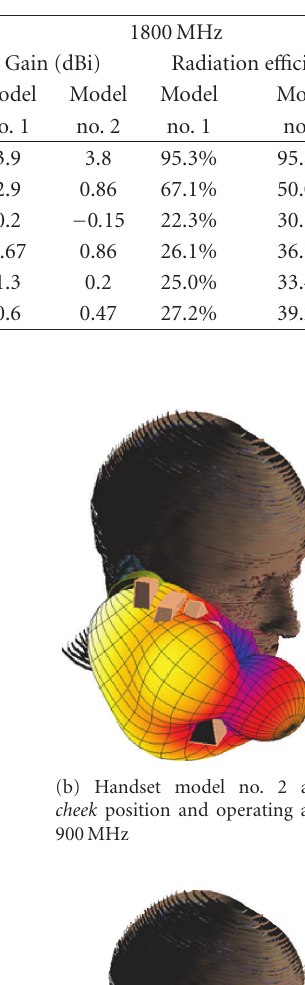
Table 4: Computational results of the antenna performance parameters of both handset models at 1800 MHz in all cases.